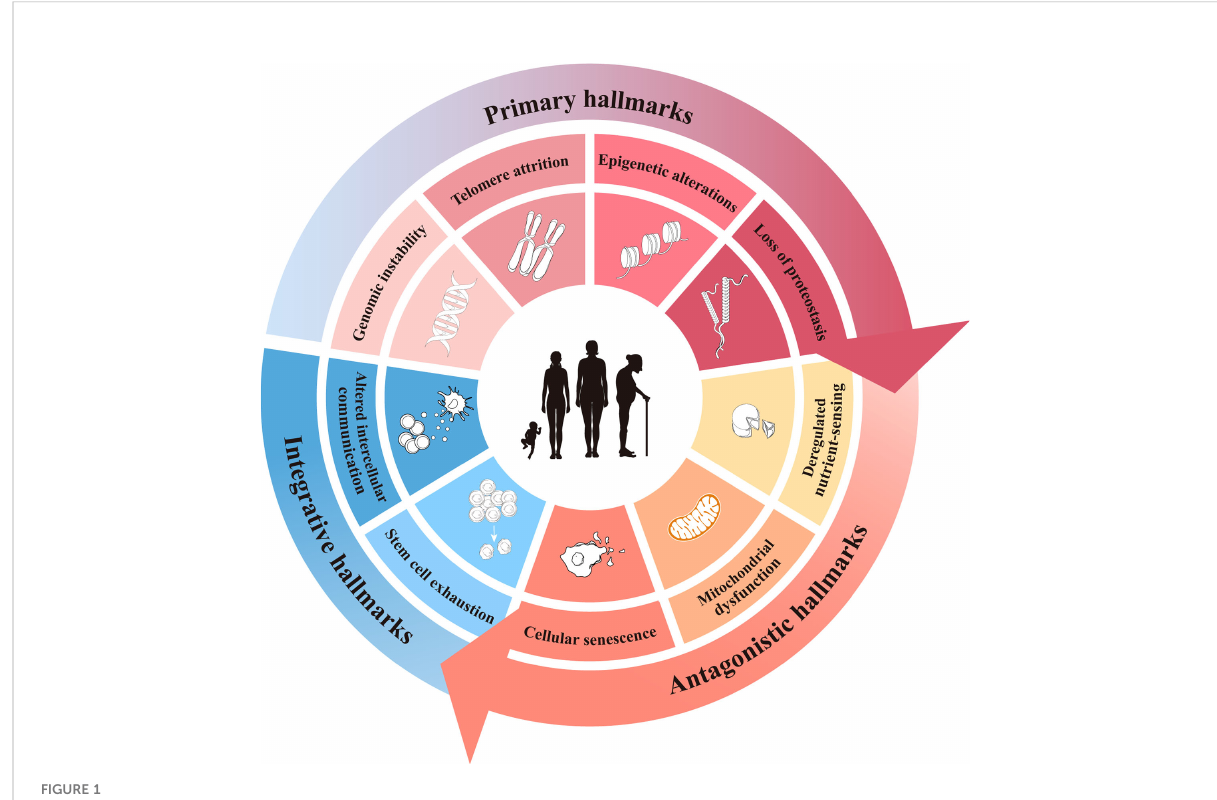
FIGURE 1 The current hallmarks of